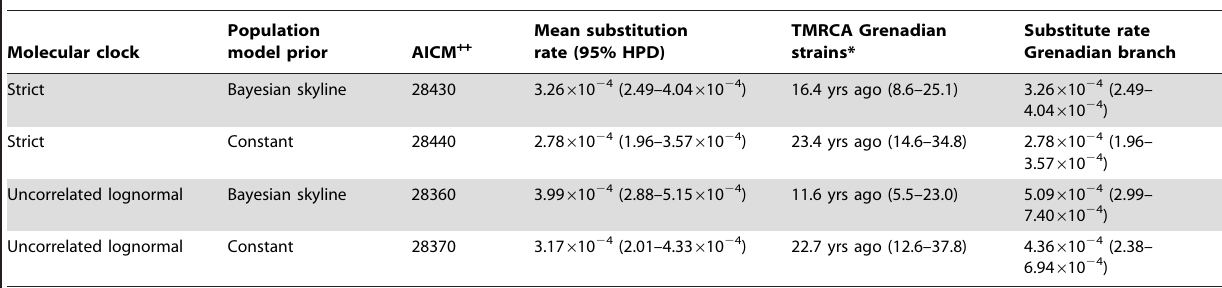
Table 2. Molecular clock model output.